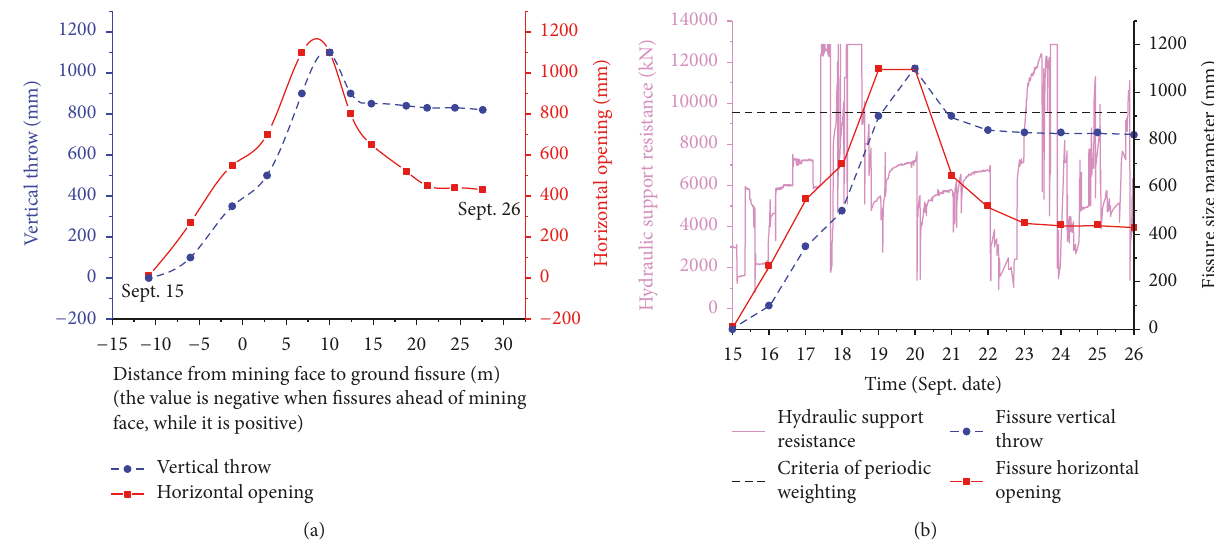
Figure 7: Dynamic development of mining-induced fissures in Working face 6104.